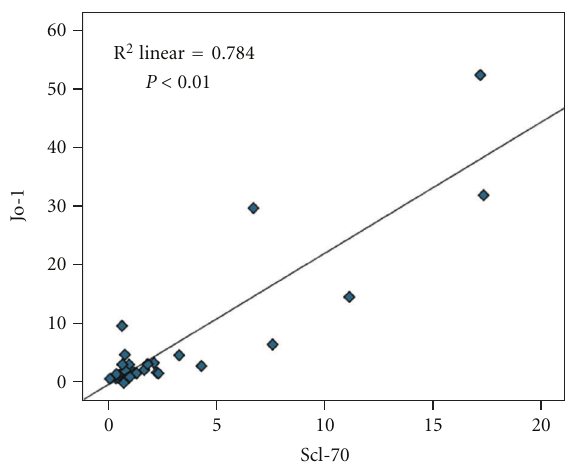
Figure 10: Spearman’s correlation analysis between SCL 70 and Jo- 1.